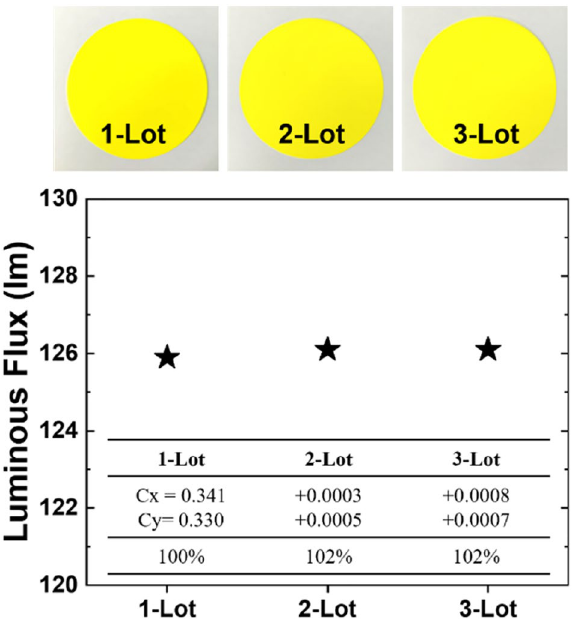
Figure 5. Reproducibility test of ceramic phosphor production using HFP sintering method.